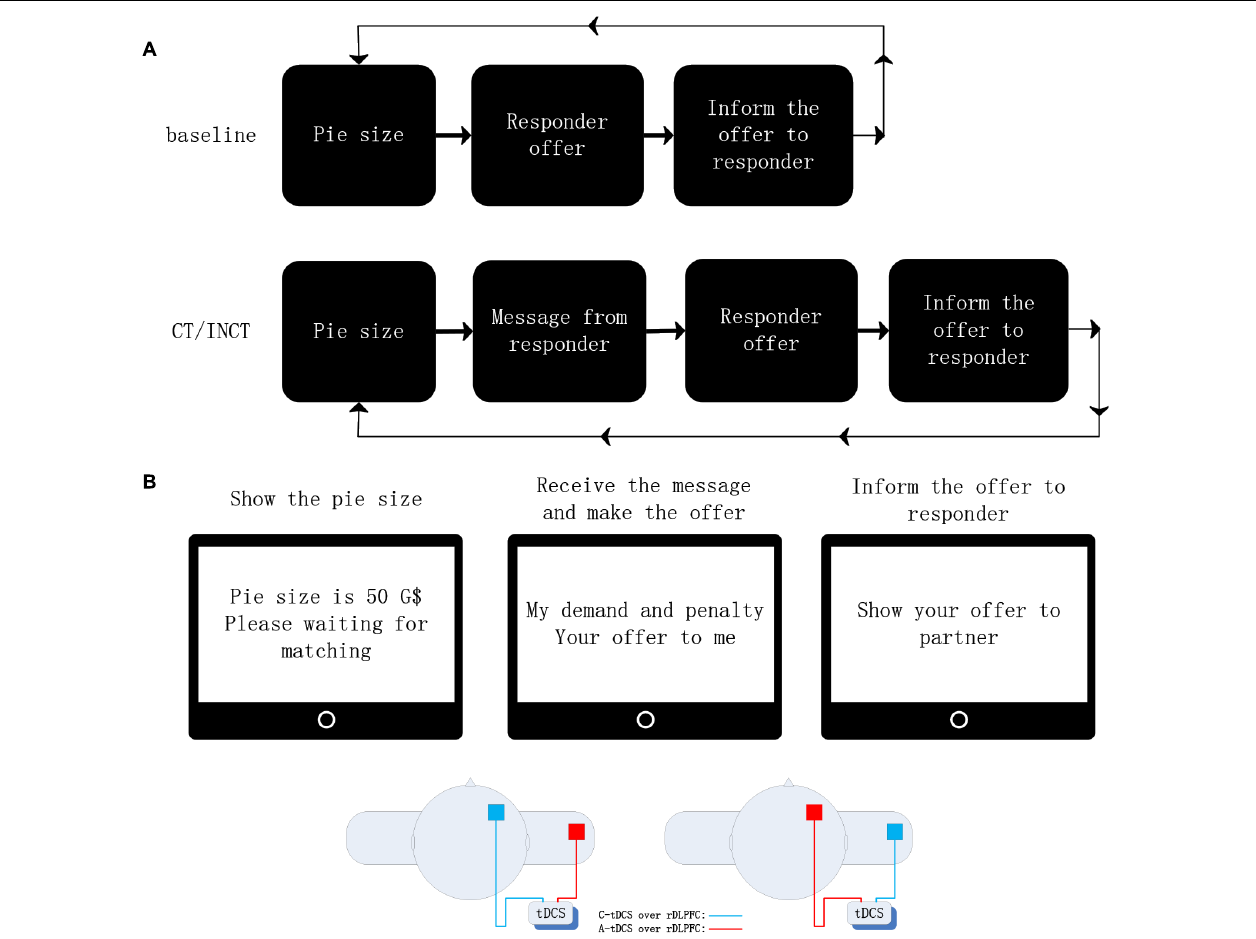
FIGURE 1 | (A) Structure of the modified UG. UG rules: The participant made an offer to the responder after he/she received a message from the responder. They were told if the responder accepted, and the money was divided as the proposer decided. If the responder rejected, they both received zero. The message had two types of information representing two types of threat, incredible threat and credible threat (INCT and CT). With each type of threat, the requested amount included a fair request and an unfair request (fair threat and unfair threat). “Fair threat” was a 25 G$ request amount, “unfair threat” was a 35 G$ request amount. The penalty represented a deduction if the responder accepted an offer lower than his/her request amount. (B) The tDCS placement is shown, representing the different stimuli conditions: cathodal stimuli, cathodal electrode over the F4 site, and extra-encephalic reference on the right shoulder; anodal stimuli, anodal electrode over the F4 site, and extra-encephalic reference on the right